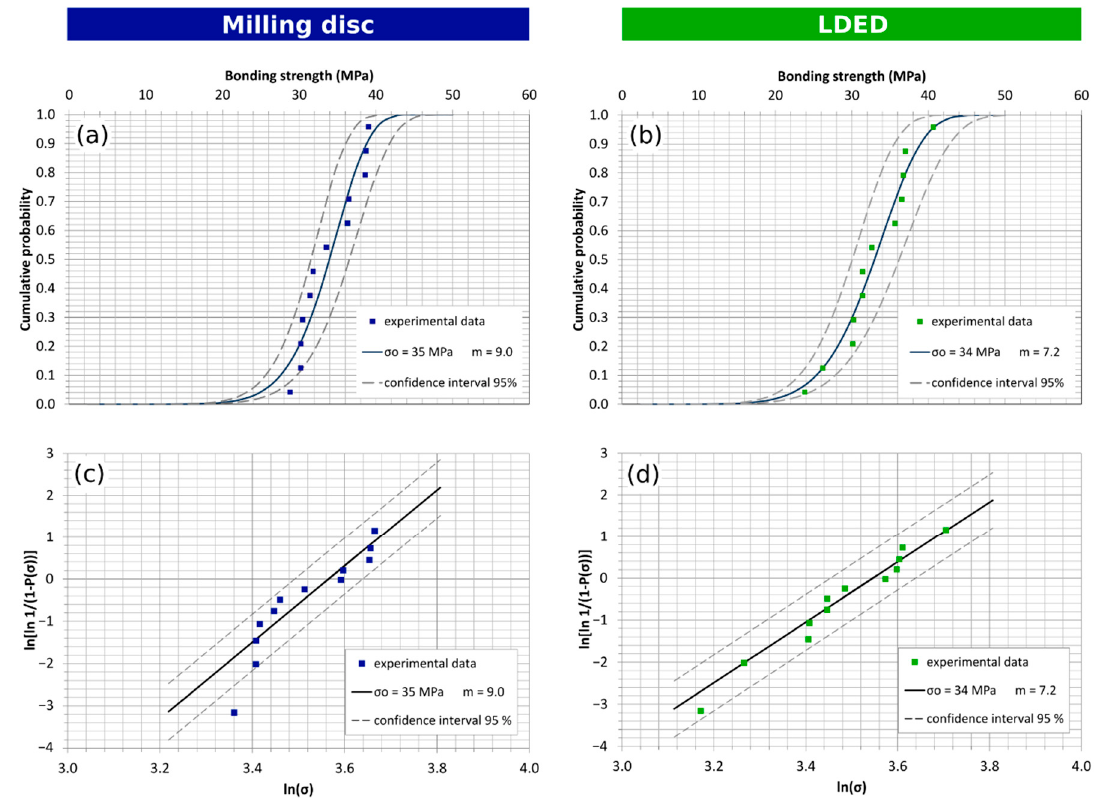
Figure 9. Bending strength test for ceramic-coated samples: Weibull plot and cumulative failure probability plot for ( a , c ) milling disc (Weibull characteristic strength σ 0 = 35 MPa; Weibull modulus m cor = 9.0); ( b , d ) LDED (Weibull characteristic strength σ 0 = 34 MPa; Weibull modulus m cor = 7.2).